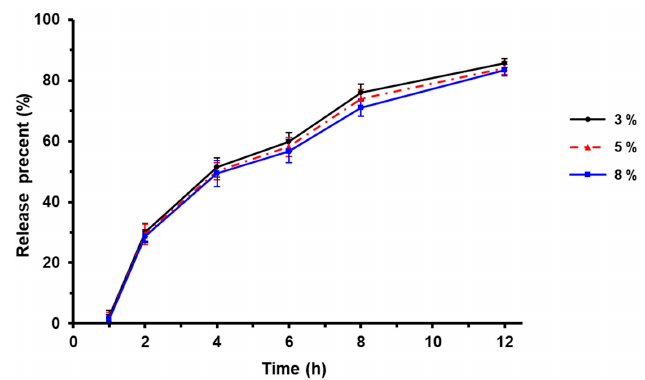
Figure 2. E ff ect of barrier layer weight on drug release ( n = 3). Figure 2. Effect of barrier layer weight on drug release ( n = 3).